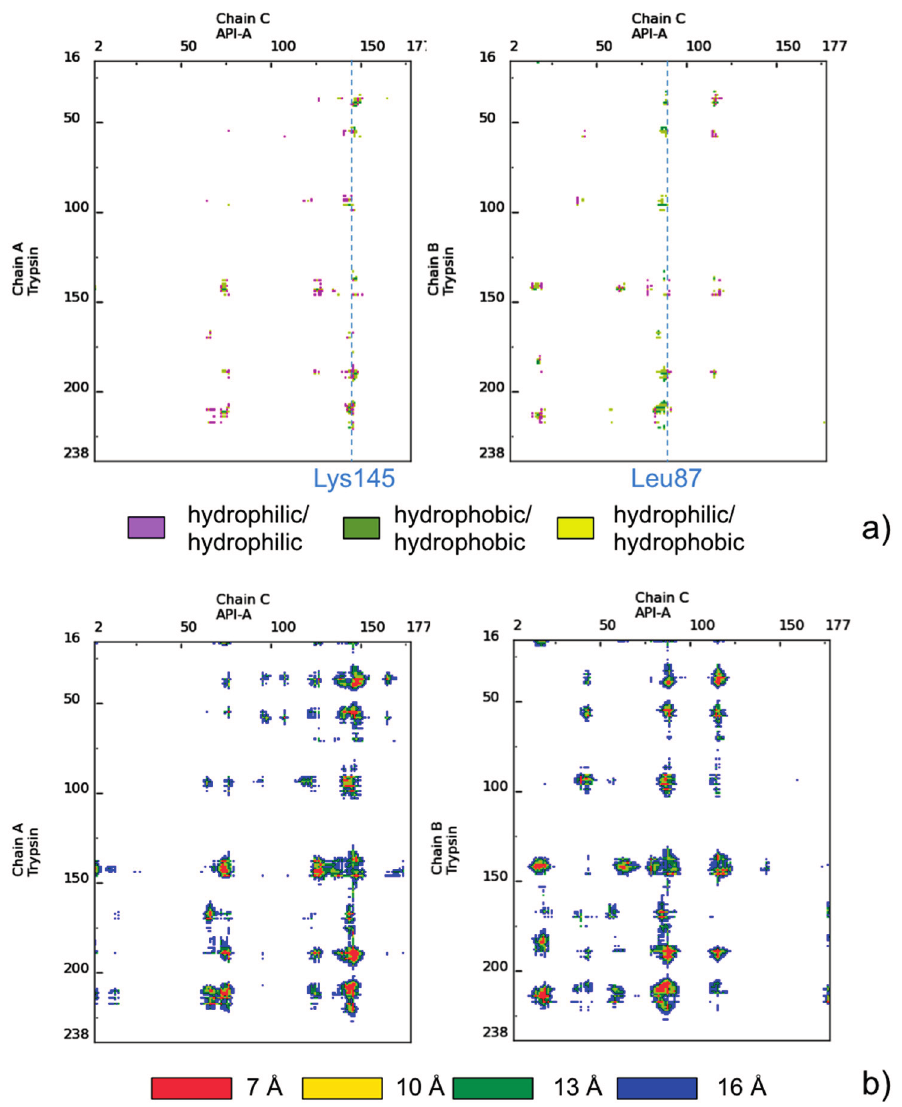
Figure 1. ( a ) COCOMAPS property contact maps and ( b ) distance contact maps for interfaces AC and BC of the trypsin-API-A complex (PDB ID: 3E8L). The color codes are reported in the legends under the